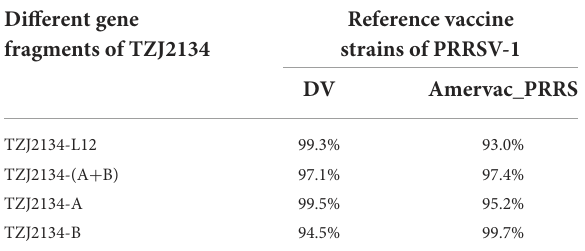
TABLE 1 Nucleotide similarity between different gene fragments of TZJ2134 and vaccine strains of